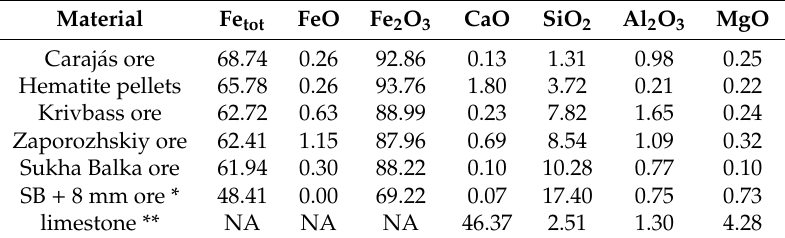
Table 1. Chemical composition of the raw materials, dried, wt.%.